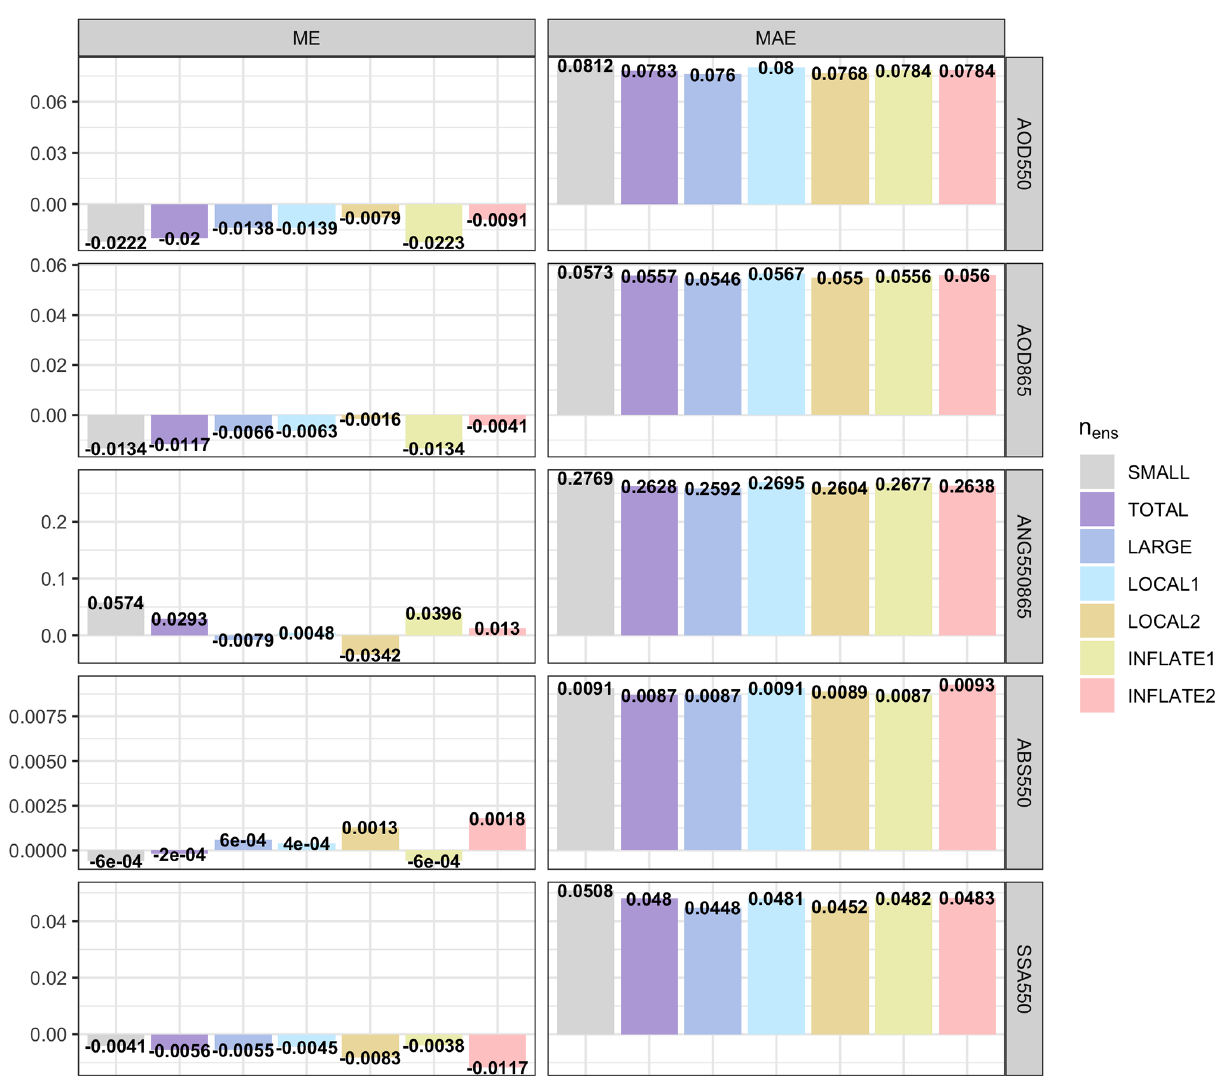
Figure 19. ME and MAE for all the spatiotemporal collocated points between POLDER (assimilated observations) and the experiments, averaged over the whole study